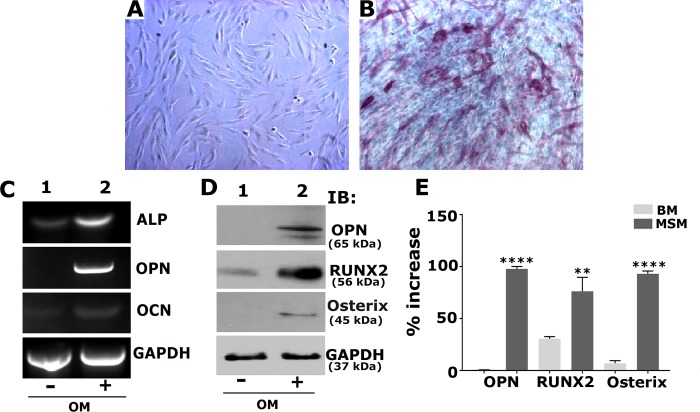
Osteogenic medium (OM) induces the expression of osteogenic markers at mRNA and protein levels in SHED cells.A and B: Phase-contrast micrographs of SHED cells at 7 days in the presence of basal (A) or osteogenic medium. Alkaline phosphatase (ALP) stained cells are shown in Panel B. Magnification is 100X. C-E: SHED cells treated with basal (-) or osteogenic medium (OM; (+)). RT-PCR (C) and immunoblotting (D) of indicated osteogenic markers to determine mRNA and protein levels, respectively. GAPDH was used as a loading control in C and D. E. Expression of OPN, RUNX2, and Osterix proteins were quantitated from three different experiments, and the expression levels are provided as the percent increase for each protein. Error bars represents SD. **** p< 0.001; **p<0.01 vs. basal medium (-).